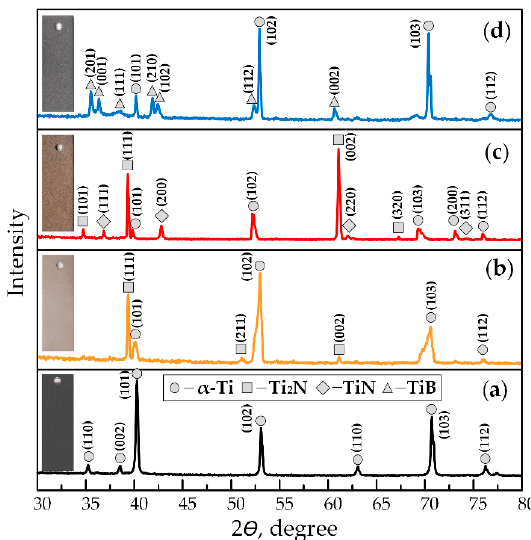
Figure 3. XRD analysis of titanium Grade 2 in the initial state ( a ), after nitriding at temperatures of ◦ C ( b ) and 900 ◦ C ( c ), and after boriding ( d 750 °C ( b ) and 900 °C ( c ), and after boriding ( d ). 750